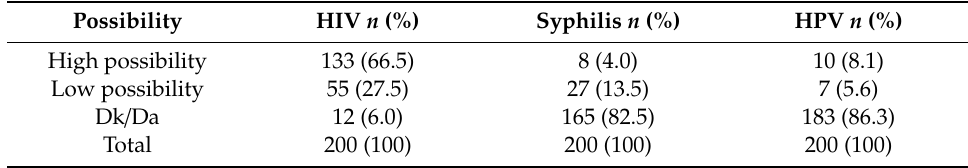
Table 4. Respondents’ perception about the possibility of contracting sexually transmitted infections (STIs).